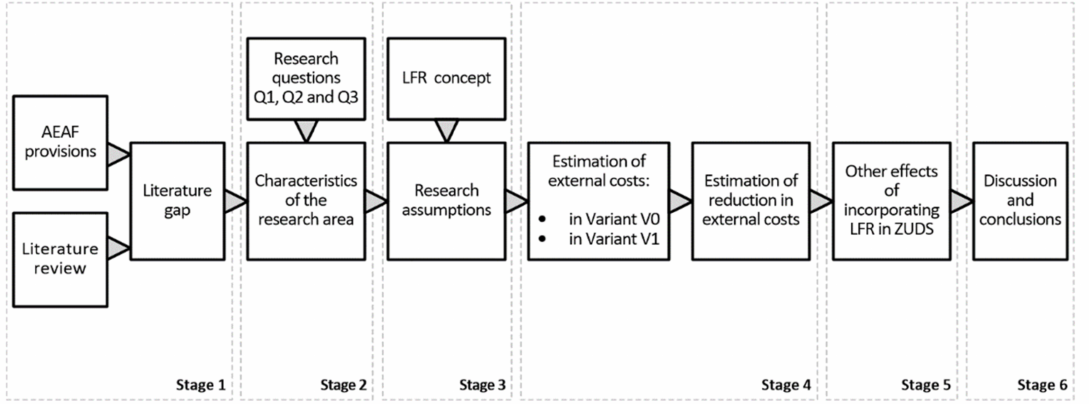
Figure 2. The research process flow